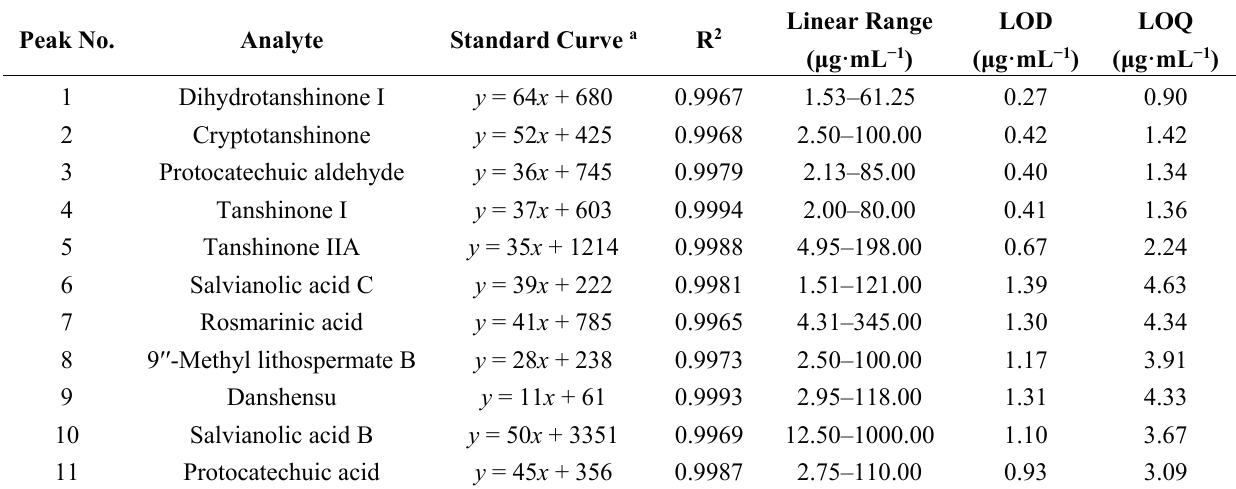
Table 1. Calibration curves, limits of detection (LODs) and limits of quantification (LOQs) of the investigated